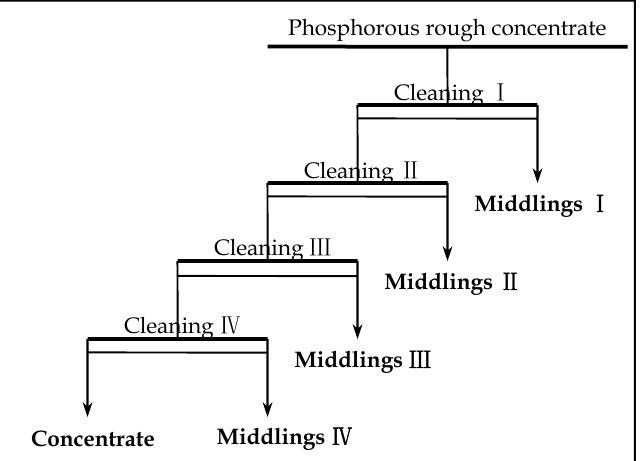
Figure 11. Time on flotation cleaning flowsheet. Table 4. E ff ect of cleaning time on P 2 O 5 grade and recovery in flotation